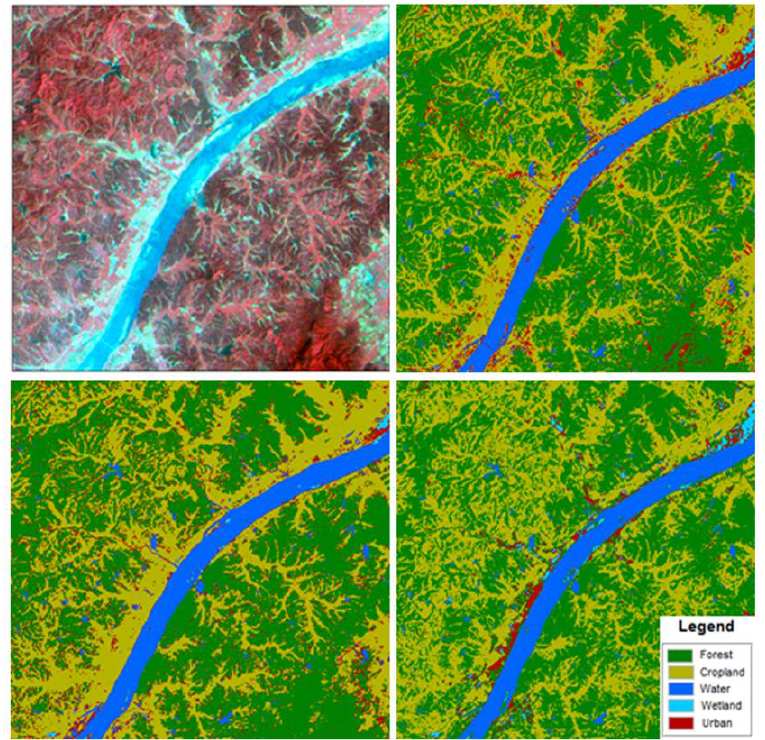
Figure 14. The subset image for area B in false-color (( upper left ) R: band 4, G: band 3, B: band 2) and classified image using ( upper right ) spectral shape-based method, ( lower left ) SVM method and ( lower right ) MD method.